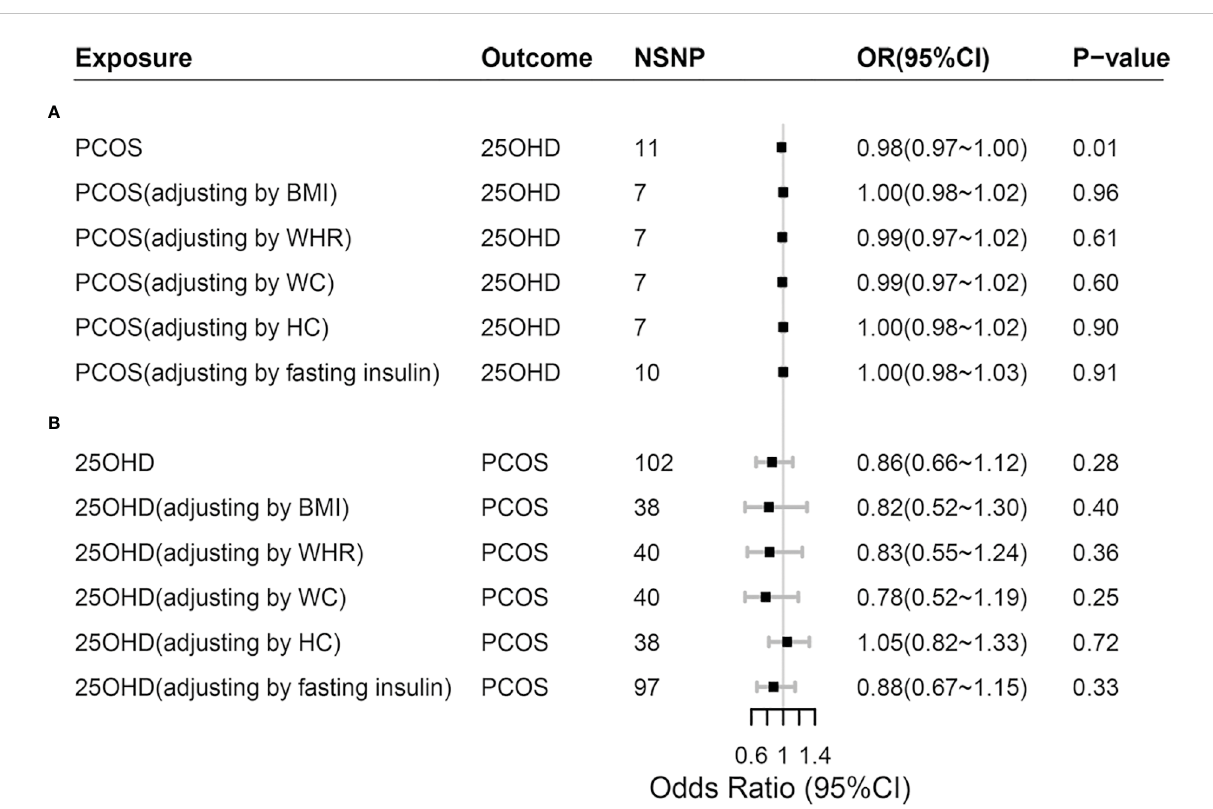
FIGURE 3 Comparisons of Mendelian randomization results. (A) Comparisons of Mendelian randomization results for PCOS on 25OHD; (B) Comparisons of Mendelian randomization results for 25OHD on PCOS. PCOS, polycystic ovary syndrome; 25OHD, 25-Hydroxyvitamin D; OR, odds ratio; 95% CI, 95% con fi dence interval; BMI, body mass index; WHR, waist-to-hip ratio; WC, waist circumference; HC, hip